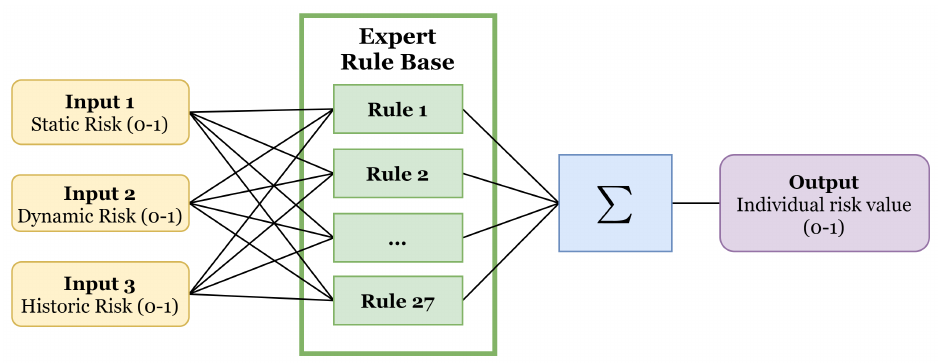
Figure 8. Fuzzy inference process.